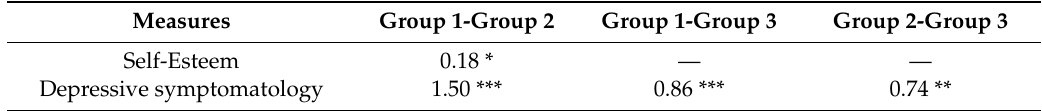
Table 4. Cohen’s indices for post-hoc contrast